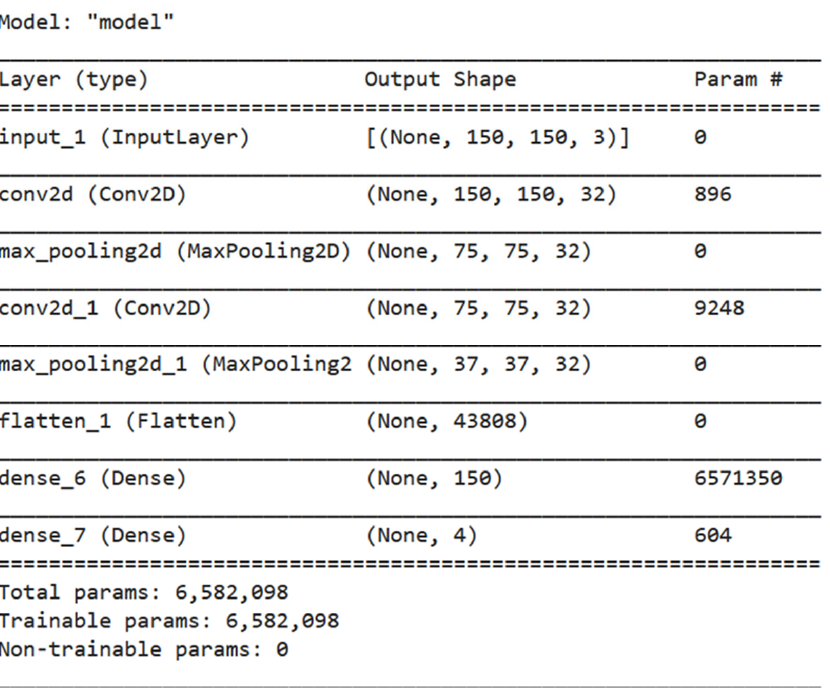
Figure 6. Model visualization to multi-classification task.